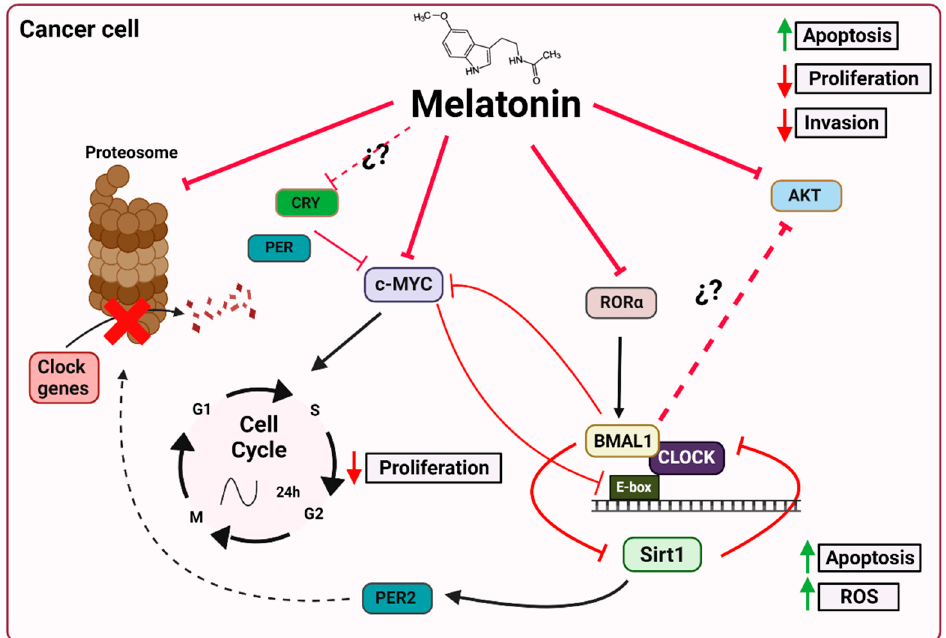
Figure 3. Proposed mechanisms by which melatonin affects the circadian machinery of cancer cells. By inhibiting the proteasome, melatonin can act post-translationally to regulate the circadian clock by stabilizing proteins, depending on the time of day and the levels of this hormone. Melatonin, together with BMAL1, PER and CRY, represses c-Myc, which arrests the cell cycle, thus decreasing cell proliferation. In addition, c-MYC binds to the E-box region and regulates the expression of certain clock genes. Through the MT1 receptor, melatonin blocks the transcription of ROR α and also the activation of BMAL1 expression, as well as of Sirt1, with consequent proapoptotic and prooxidant effects. In addition, SIRT1 regulates BMAL1 by controlling acetylation levels and PER2 promoting its degradation. Melatonin inhibits the AKT pathway, which may occur via BMAL1. The inhibition of this pathway causes an increase in apoptosis and a decrease in cell proliferation and invasion. Brain and muscle aryl hydrocarbon receptor nuclear translocator-like protein 1 (Bmal1); circadian locomotor output cycles kaput (Clock); Chryptochrome (Cry); Period (Per); orphan retinoic acid receptor-related alpha (ROR α ); reactive oxygen species (ROS); sirtuin 1 (Sirt1). Image created using BioRender.com (accessed on 28 December 2022).